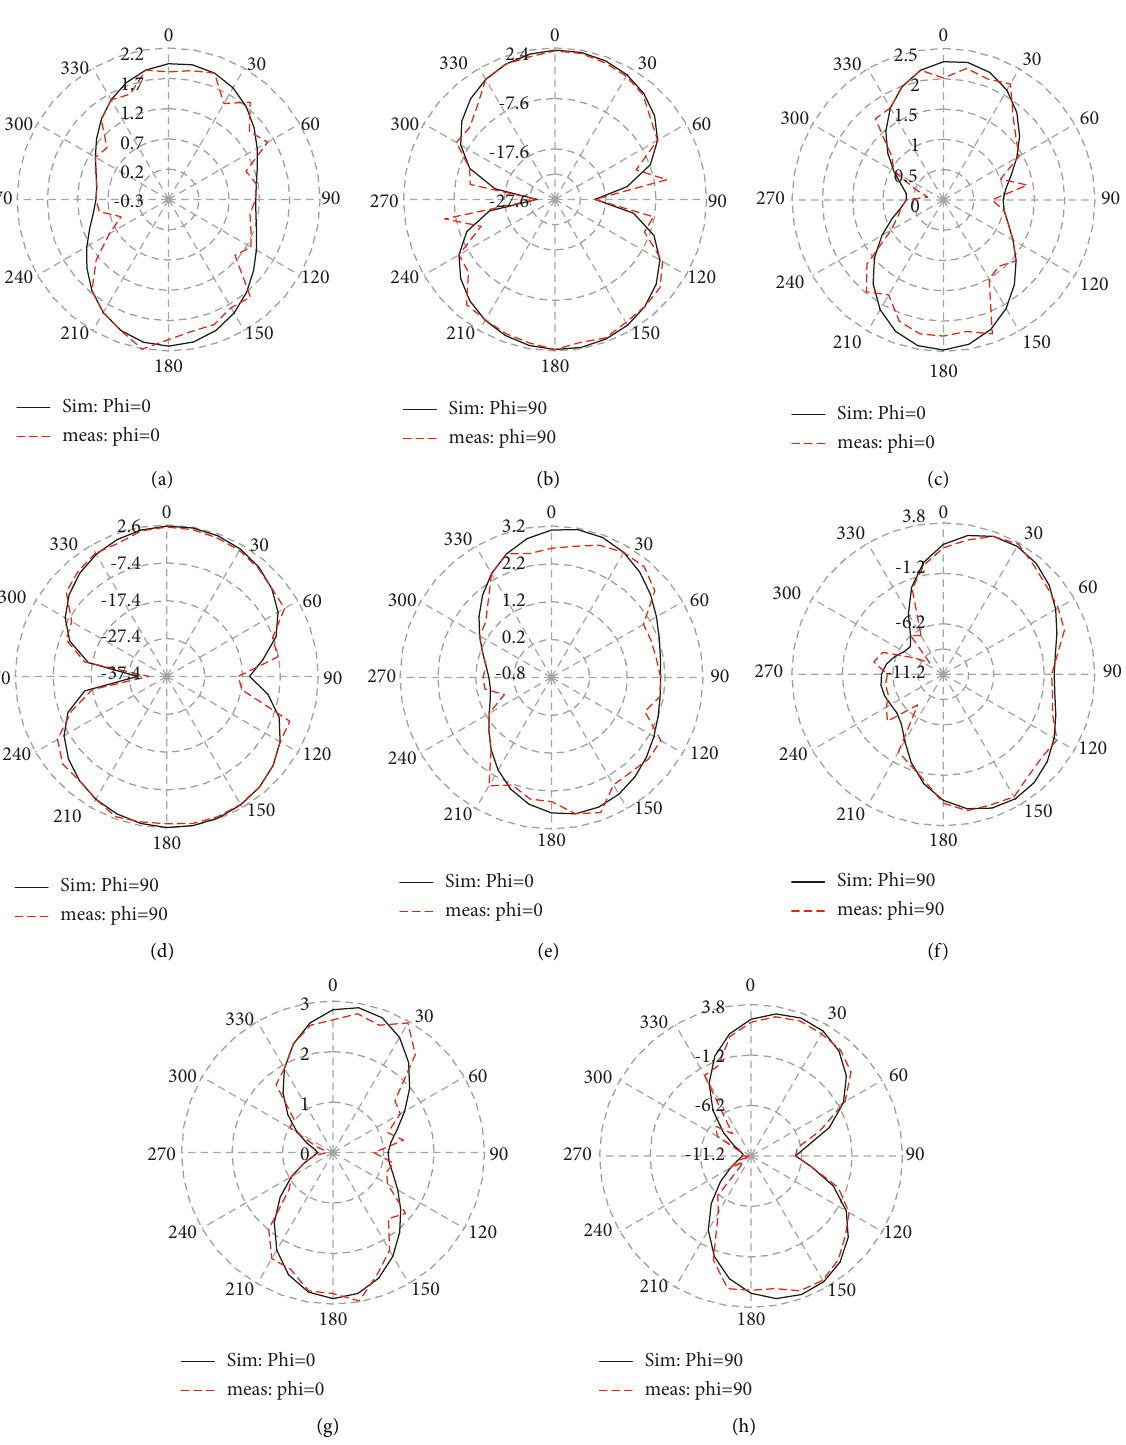
Figure 7: Simulated and measured radiation pattern of the proposed wideband circular-slot antenna for Phi � 0 o and Phi � 90 o : (a, b) at 1.8GHz, (c, d) at 2.1GHz, (e, f) at 2.45 GHz, and (g, h) at 2.65GHz,